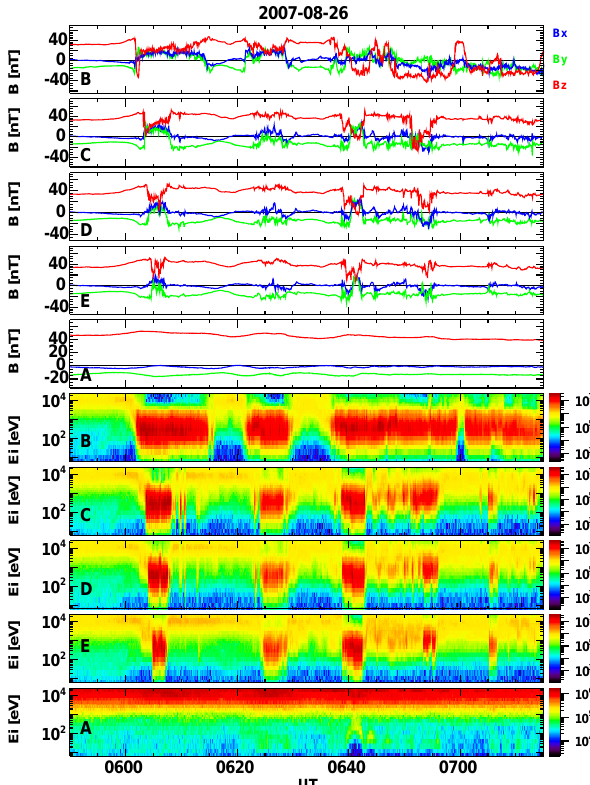
Fig. 1. Overview of THEMIS observations on 26 August 2007 from 05:50 to 07:15UT. From top to bottom: magnetic fields measured by THB, THC, THD, THE and THA, respectively; ion spectra reg- istered by all THEMIS probes in the same